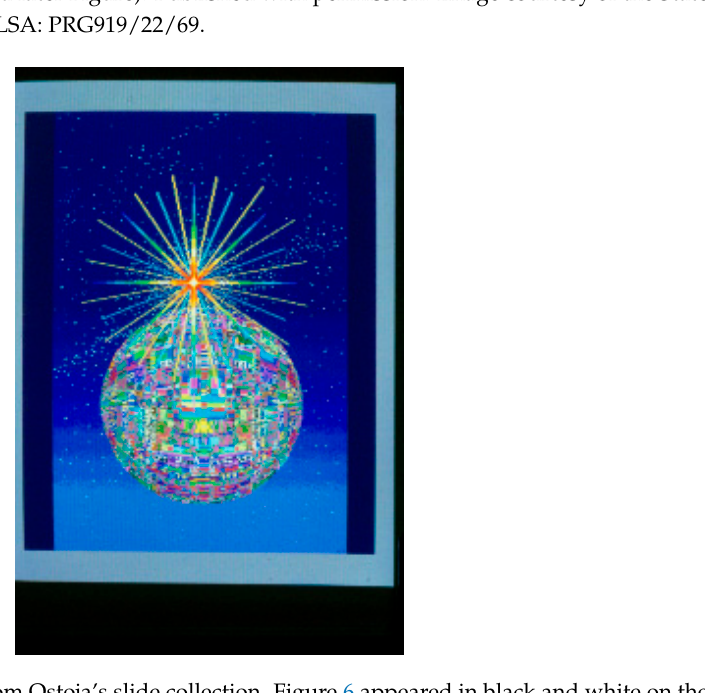
Figure 6. Unnamed image from Ostoja’s slide collection. Figure 6 appeared in black and white on the front of the Adelaide Beebnet computer user group printed newsletter. Published with permission. Image courtesy of the State Library of South Australia. SLSA: PRG919/22/464.